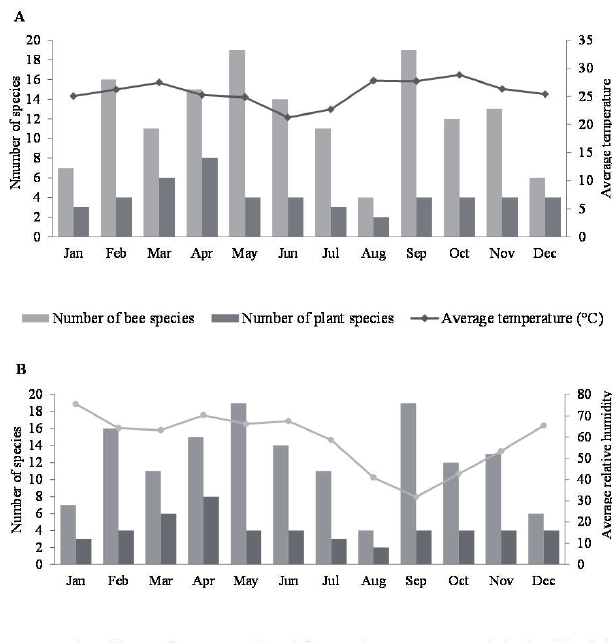
Fig 3 . Richness of bees and plants and averages of abiotic data collected throughout the year of study at “Fazenda São José”, Uberlândia-MG. (A) Average temperature. (B) Average relative